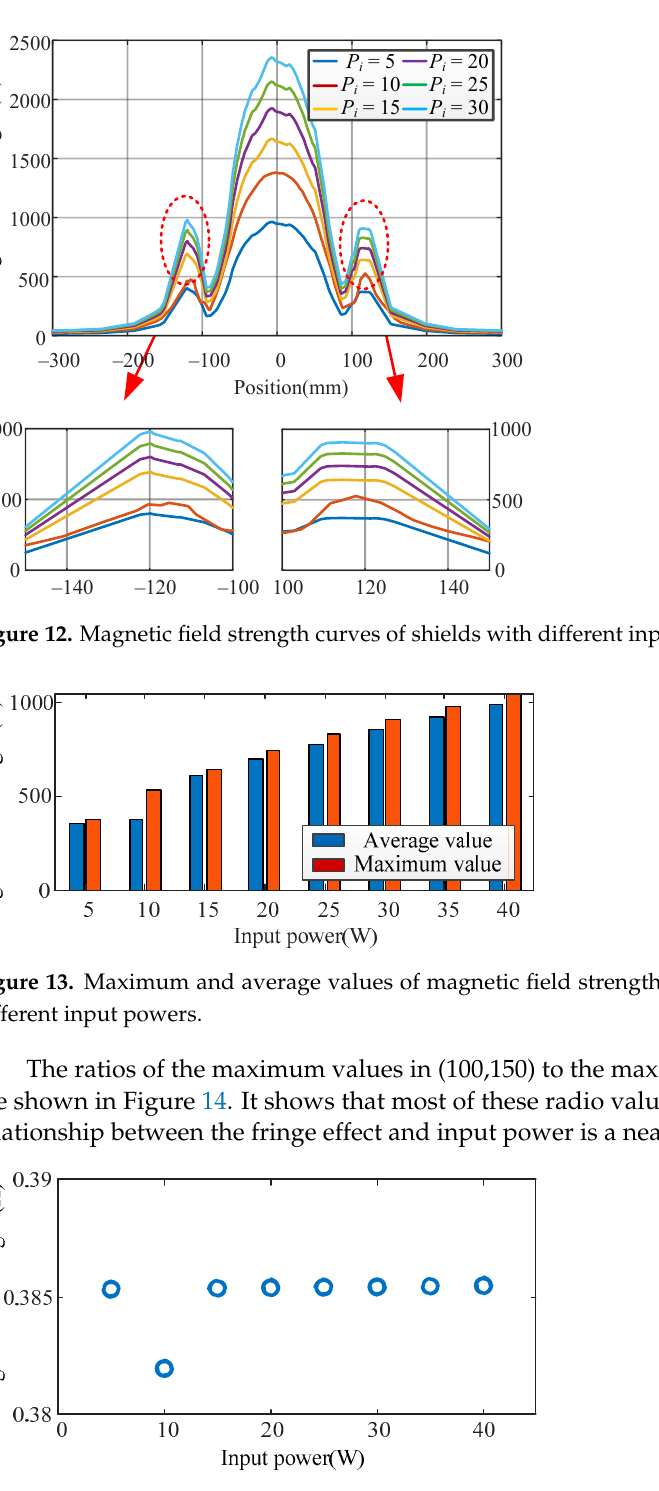
Figure 14. The ratios of the maximum values in (100,150) to the maximum values in (− 300,300).